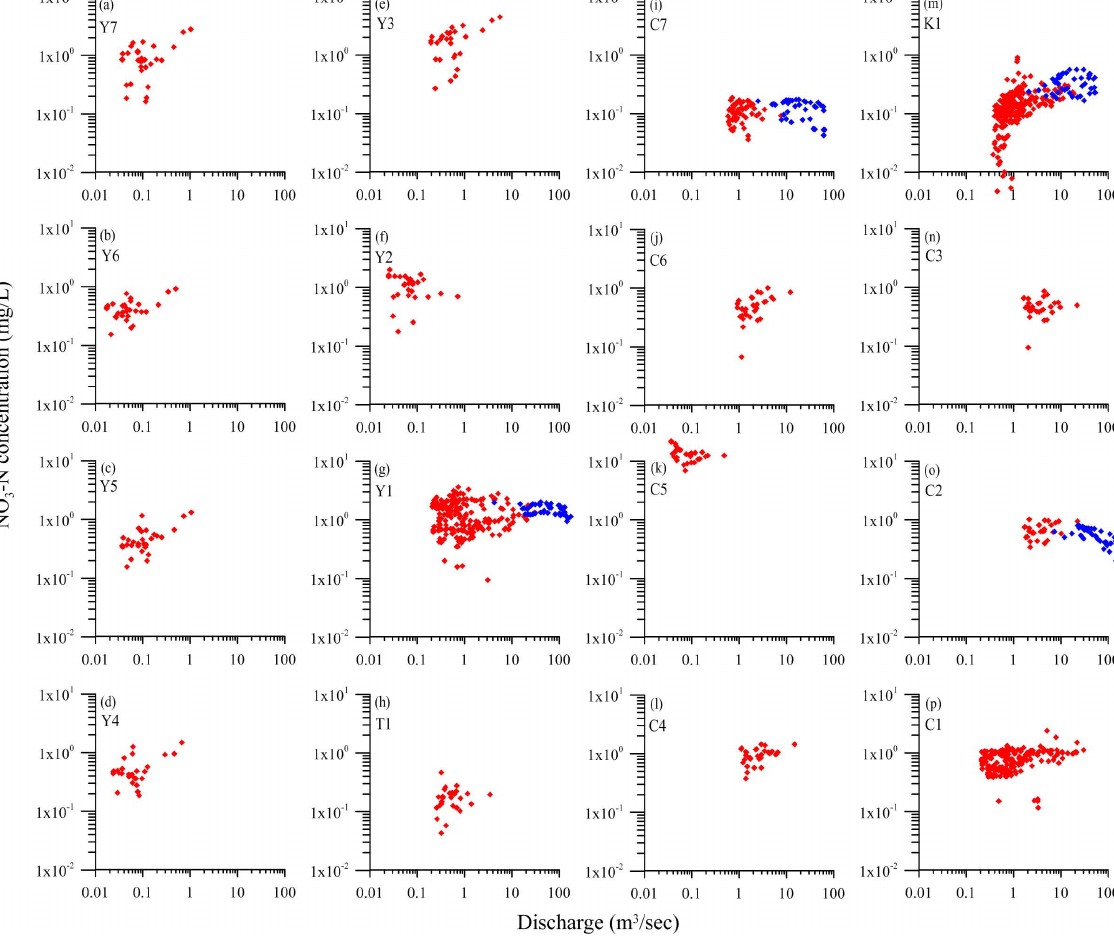
Fig. 4. The relationship between the monitored NO 3 -N concentration (y-axis) and the daily discharge (x-axis) on the sampling date over the entire sampling sites. The blue circles indicate the typhoon